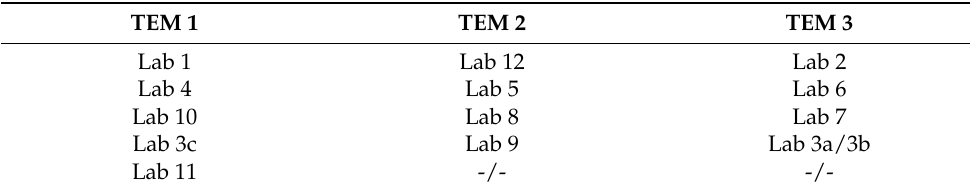
Table 2. Distribution pattern of the RR campaign. The order of listed laboratories corresponds to the chronological order of conducted measurements on a particular TEM